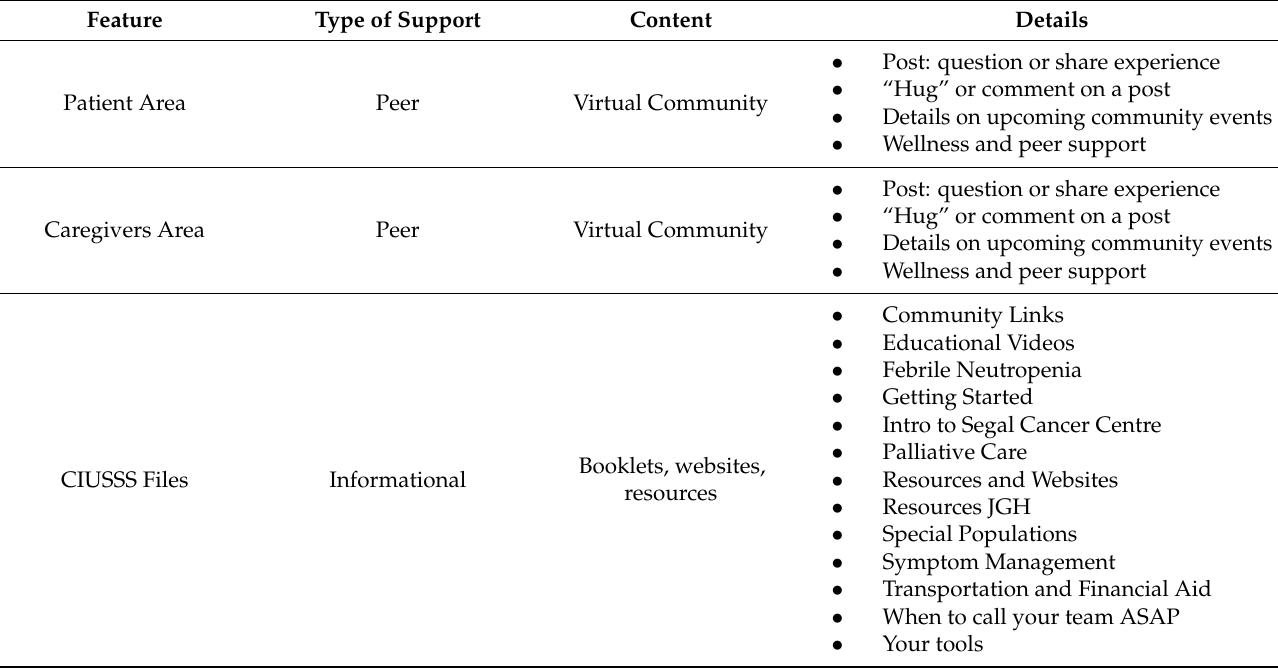
Table 2. Overview of features available in BELONG for the CIUSSS closed